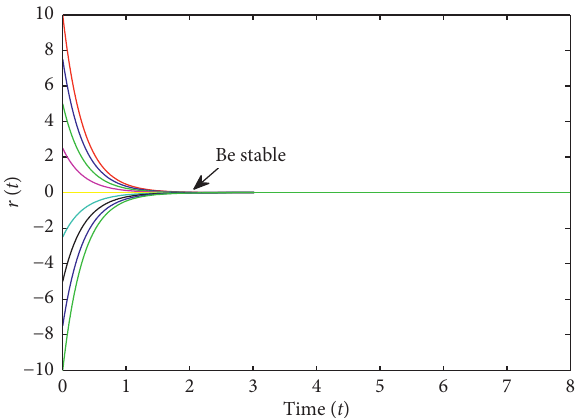
Figure 6: The EGS of r ( t ) with k � 0 . 01 and θ � 0 . 1 in (45). Figure 9: Unstable trajectory of r ( t ) of (45) with k � 1 . 02, θ � 0 .